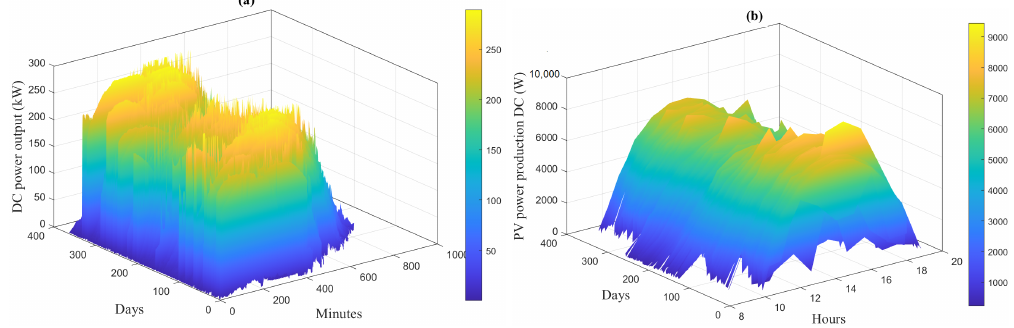
Figure 5. ( a ) distribution of solar PV power output from Parking Lot Canopy Array dataset. ( b ) Hourly distribution of solar PV power output from January to December 2018.